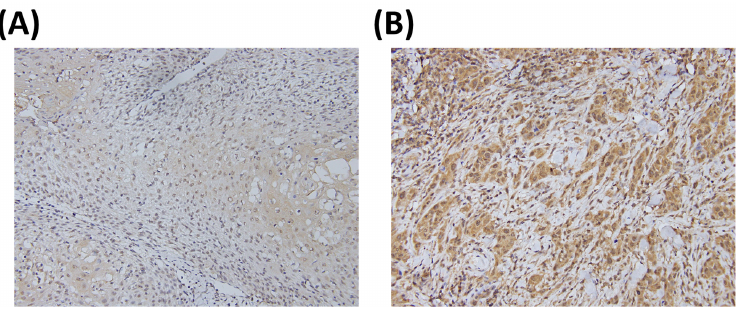
Figure 1. Representative immunostaining of KLF10 in oral squamous cell carcinoma (OSCC) specimens. The KLF10 expression levels were ( A ) low and ( B ) high.